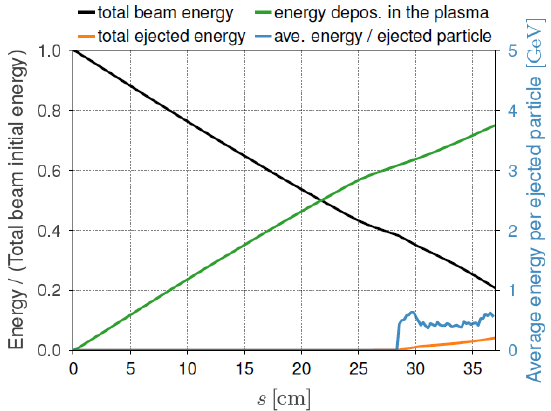
Figure 8. The energy plots as a function of propagation distance in plasma, for the plasma density profile shown in Figure 6 for the EuPRAXIA 5 GeV beam.